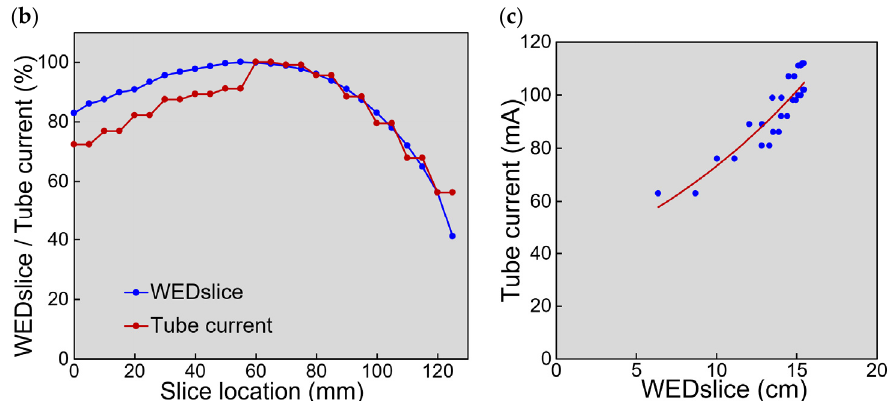
Figure 2. Tube current modulation in a 1.8-year-old male patient. ( a ) The localizer image is presented with red lines indicating the scan range. ( b ) WEDslice (blue) and tube current (red) are expressed as percentages of their maximum values and presented along the slice location. The slice location 0 corresponds to the most caudal slice. ( c ) The relationship between tube current and WEDslice. The red line represents an exponential regression curve (y = 38.17e 0.0653x , R 2 = 0.845). Pooled analysis of the 20 image sets demonstrated that tube current increased with increasing WEDslice (Figure 3a). An exponential curve was well-fitted to the plots of tube current against WEDslice; however, plots with small WEDslice values tended to be present above the fitting curve. Excluding the most cranial slice of each image set improved exponential curve fitting (Figure 3b).